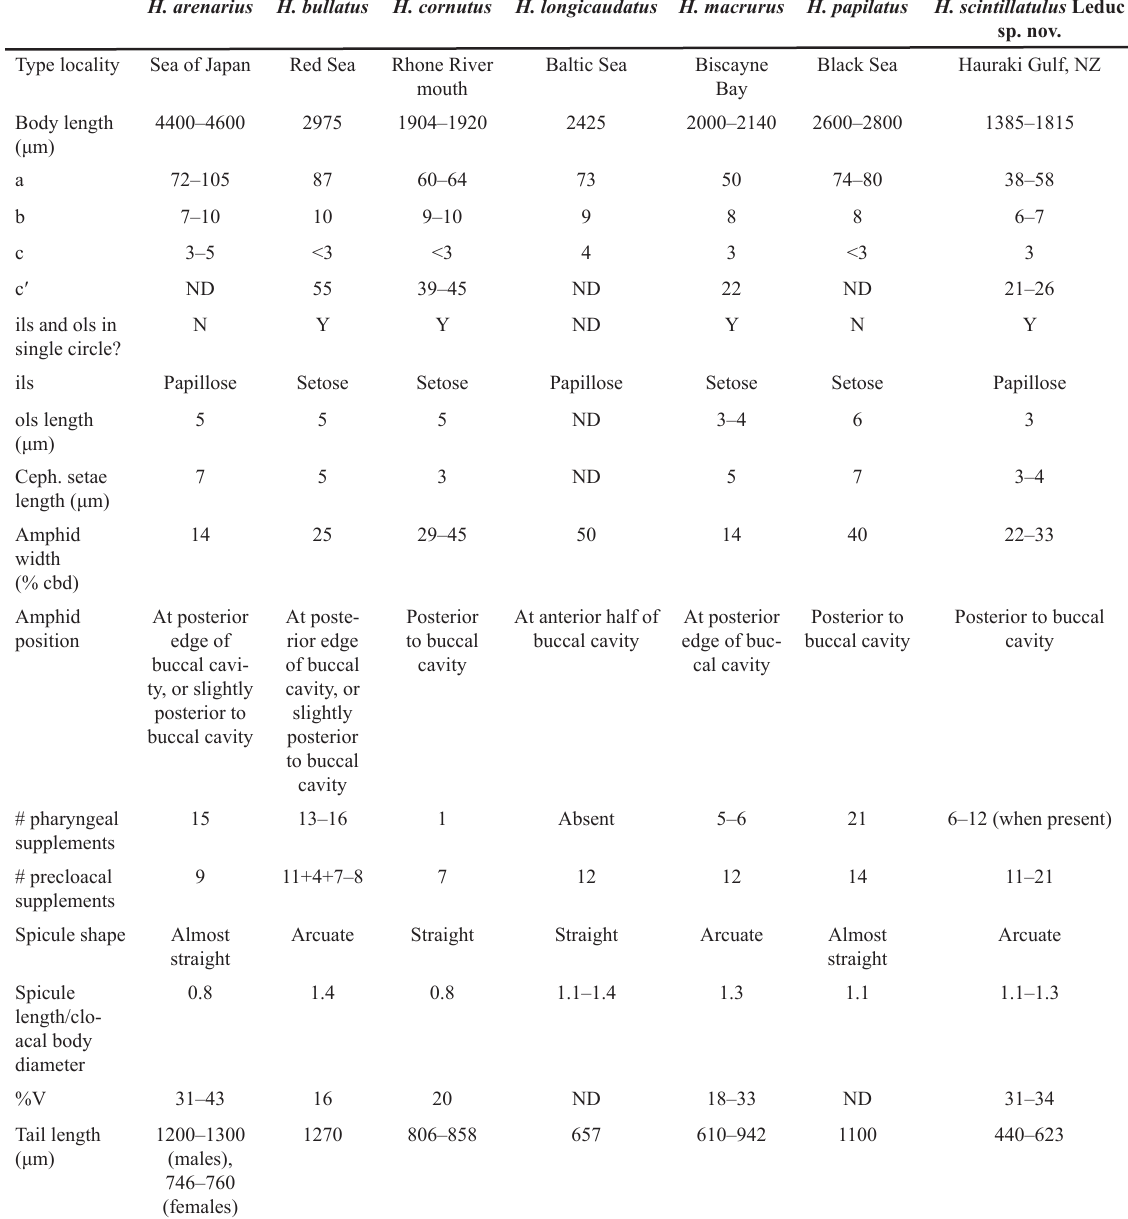
Table 3. Key morphological characters of all valid Halanonchus species. Abbreviations: N = no; ND = no data; Y = yes; otherwise, see Material and